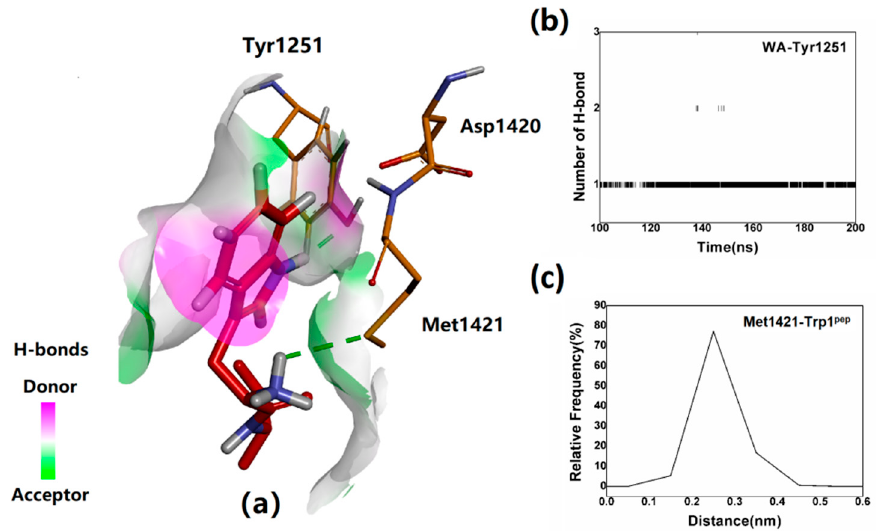
Figure 7. ( a ) The H ‐ bonds mode of MGAM ‐ WA from cluster 1, ( b ) the number of H ‐ bonds between WA and Asp1420, and ( c ) the distance distribution between the amino group of Trp1 pep and the sulfur atoms of Met1421.